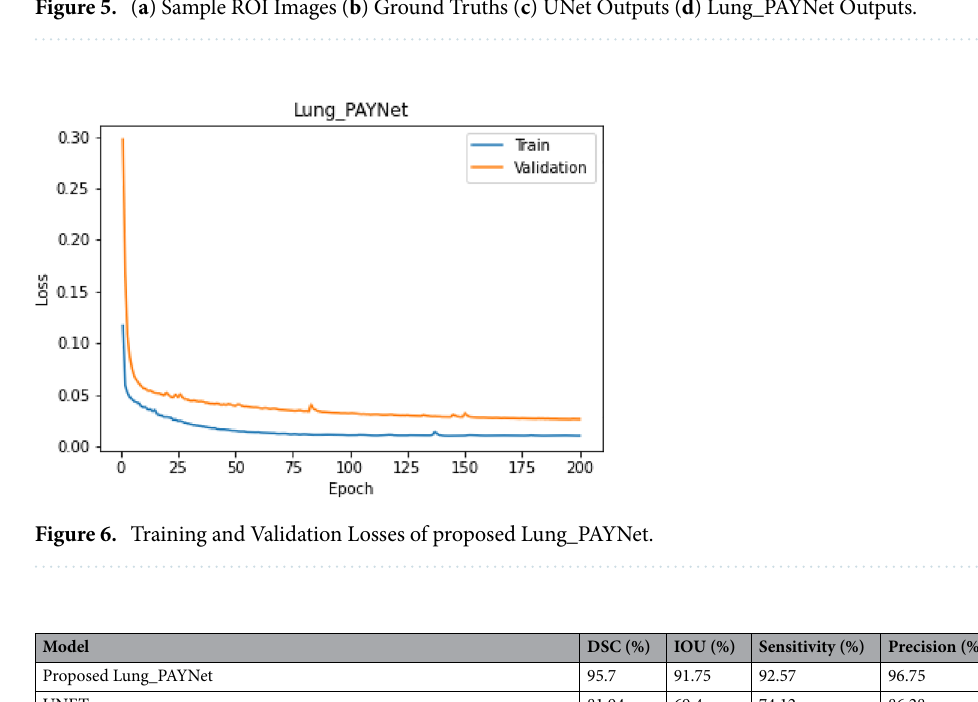
Figure 5. ( a ) Sample ROI Images ( b ) Ground Truths ( c ) UNet Outputs ( d ) Lung_PAYNet Outputs.